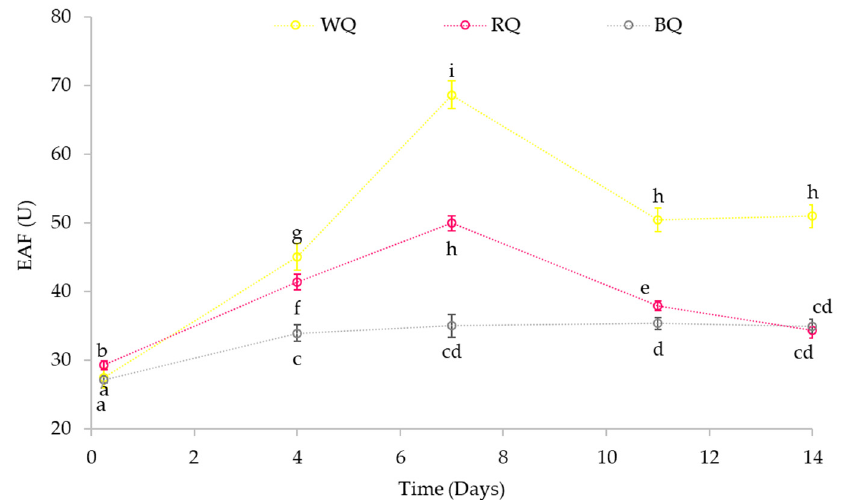
Figure 6. Effect of germination and refrigerated storage on phytase enzymatic activity in three varieties of quinoa: white (WQ), red (RQ), and black (BQ). Error bars indicate standard deviation ( n = 3). Results with different letters are significantly different at p ≤ 0.05.